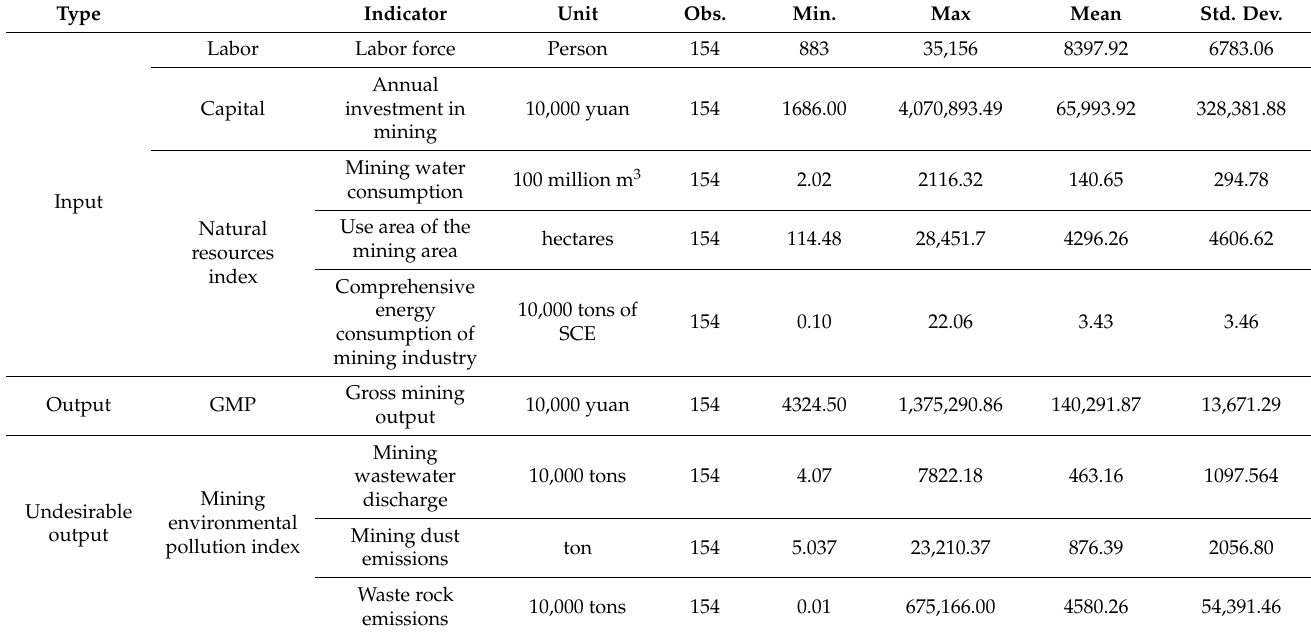
Table 2. The selection of input indicators and output